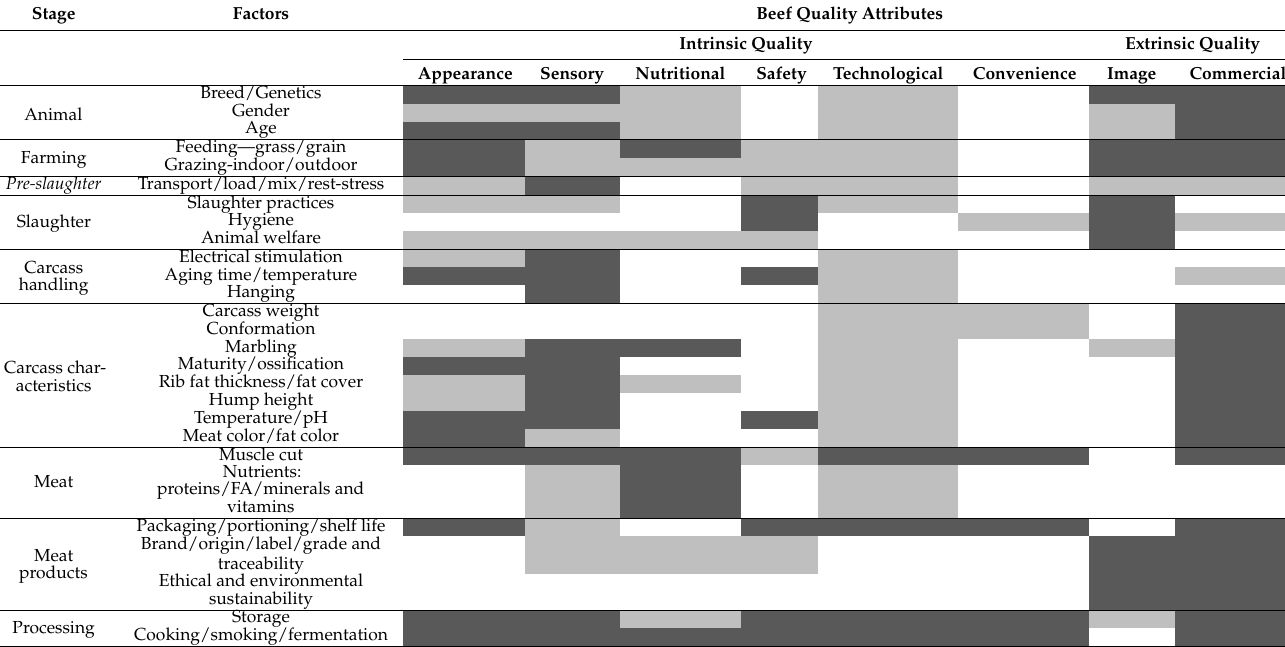
Table 1. Factors affecting the major quality attributes of beef at various stages of the farm-to-fork